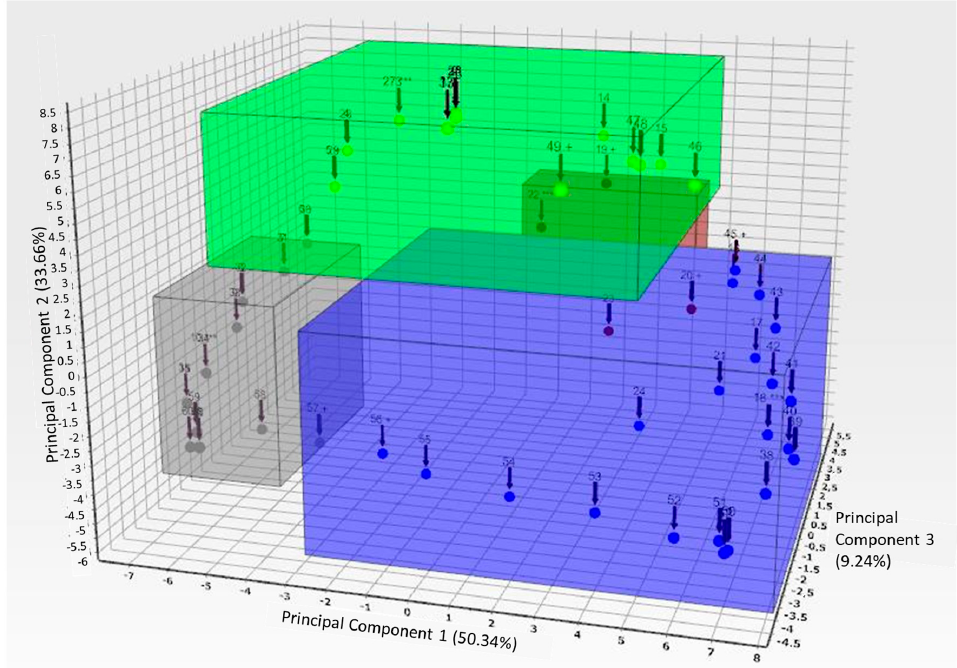
Figure 32. Separate clusters of three binary and one ternary mixture of minerals orthoclase, quartz, and spodumene.